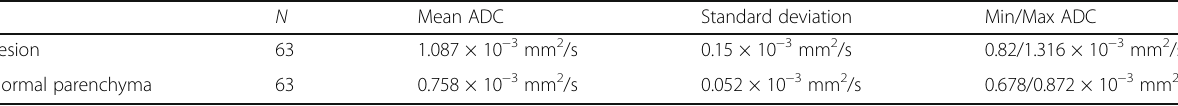
Table 6 ADC values obtained from lesional and symmetric healthy parenchyma N Mean ADC Standard